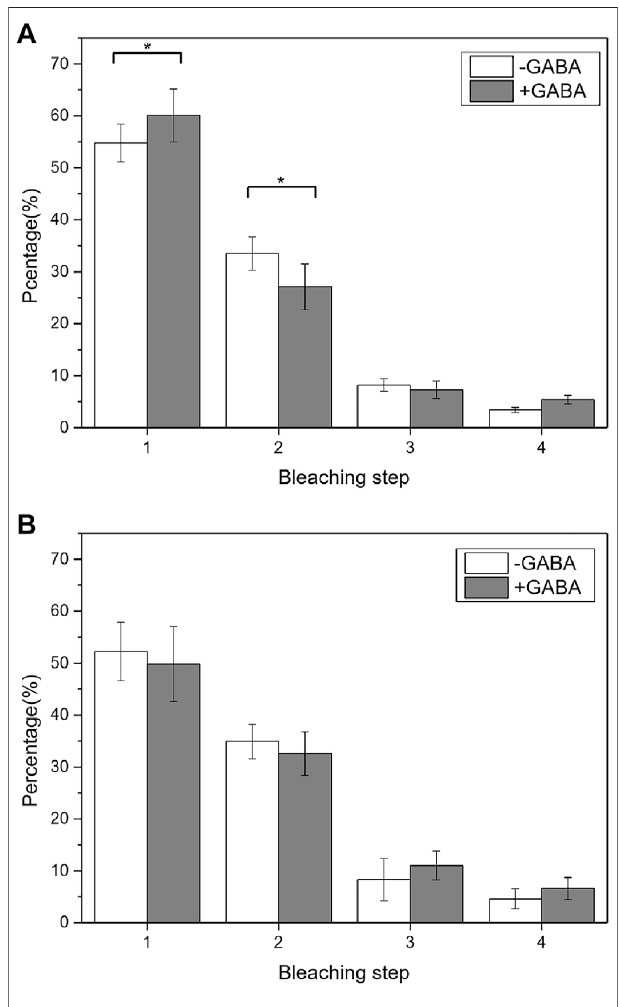
FIGURE 5 | Aggregation state changed before and after the receptor stimulation at different levels of the GABABR expression. (A) At the low GABABR expression level, the comparison of GABAB receptor population with different photobleaching steps before and after GABA treatment indicated the aggregation state was changed ( p (cid:2) 0.03176 < 0.05, Mann – Whitney U test). (B) At the high-level GABABR expression, the comparison of GABAB receptor population with different photobleaching steps. There was no signi fi cant change in aggregation before and after ligand stimulation. 20 cells and more than 2000 fl uorescent dots were used for the data analysis.